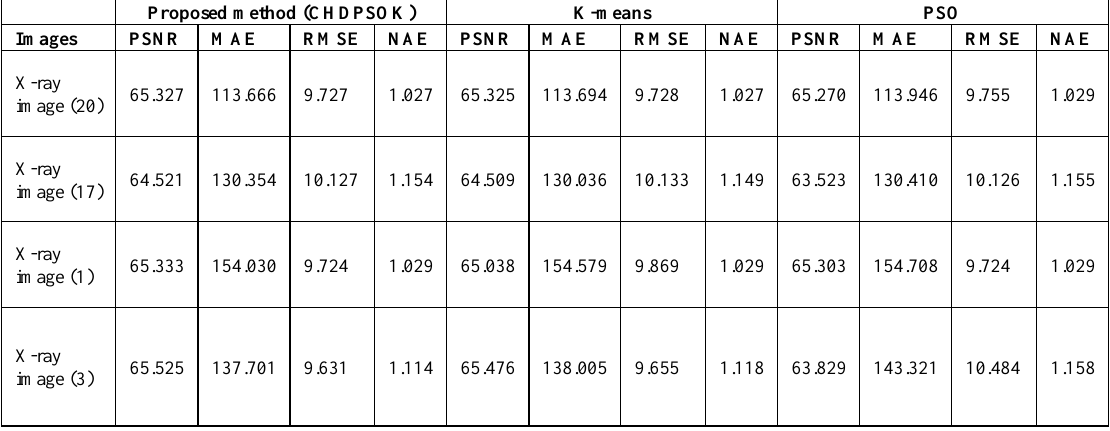
Table 1. Comparison of the proposed approach with standard K-means algorithm on segmented images. Proposed method (CHDPSOK) K-means PSO Images